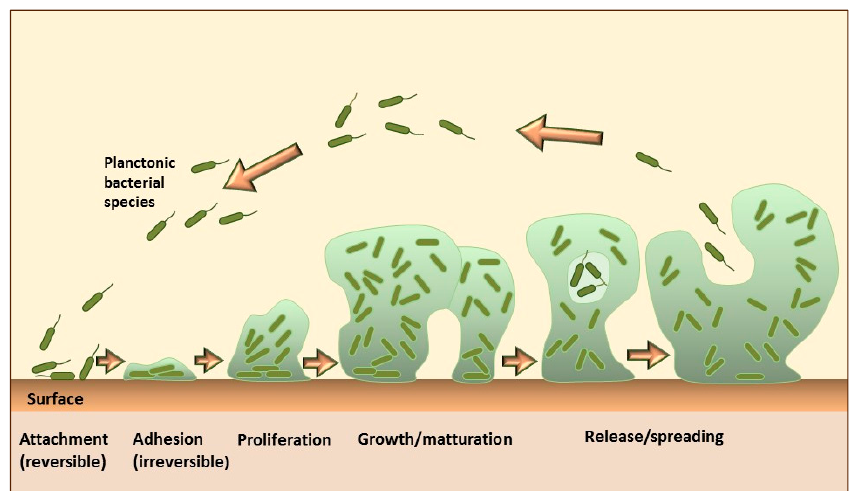
Figure 1. Schematic drawing of biofilm formation (adapted from [6,7]).